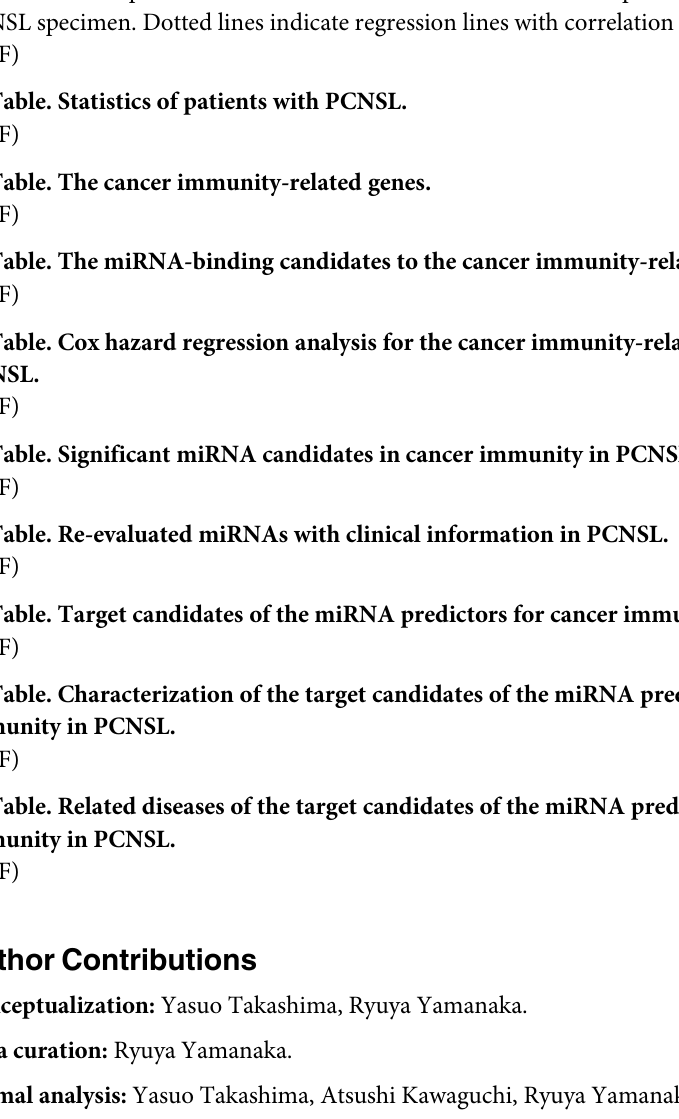
S3 Fig. Kaplan-Meier analysis based on the hierarchical cluster method for the expression of miRNAs in 20 PCNSL patients. ( A ) Cancer immunity and immune checkpoint (stimula- tory and inhibitory checkpoints). ( B ) Th-1 or Th-2 helper T-cell status. ( C ) T-reg status. HR; hazard ratio, OS; overall survival. S4 Fig. The correlation of the expression of the representative miRNAs between the micro- array and the qPCR. ( A ) hsa-miR-101, ( B ) hsa-miR-1202, ( C ) hsa-miR-548b, and ( D ) hsa- miR-554. Scatter plots were shown with statistic results. Blue dot represents a value in the PCNSL specimen. Dotted lines indicate regression lines with correlation coefficient (r). S1 Table. Statistics of patients with PCNSL. S2 Table. The cancer immunity-related genes. S3 Table. The miRNA-binding candidates to the cancer immunity-related genes. S4 Table. Cox hazard regression analysis for the cancer immunity-related miRNAs in PCNSL. S5 Table. Significant miRNA candidates in cancer immunity in PCNSL. S6 Table. Re-evaluated miRNAs with clinical information in PCNSL. S7 Table. Target candidates of the miRNA predictors for cancer immunity in PCNSL. S8 Table. Characterization of the target candidates of the miRNA predictors for cancer immunity in PCNSL. S9 Table. Related diseases of the target candidates of the miRNA predictors for cancer immunity in